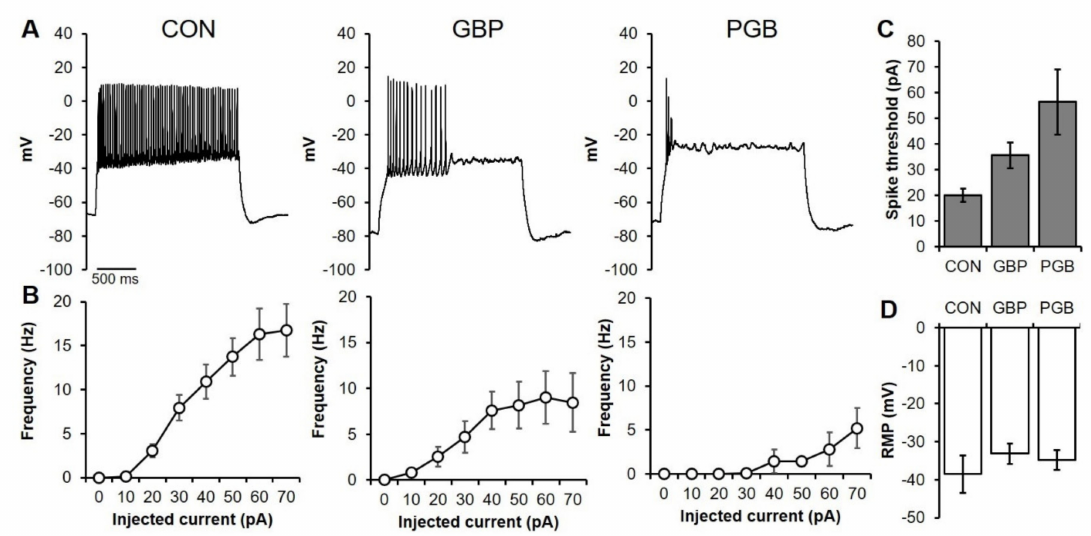
Figure 5. Electrophysiological characterization of primary cortical neurons which were chronically exposed to VGCC blockers. ( A ) Representative traces from intracellular recordings of neurons which were exposed to media only (CON, left ), or chronic administrations of either 100 µ M GBP ( middle ) or 100 µ M PGB ( right ). ( B ) Frequency of action potentials upon injection of a current are plotted for each condition. ( C ) Mean spike thresholds and ( D ) mean resting membrane potentials are shown. (CON n = 6; GBP, n = 9; PGB, n =